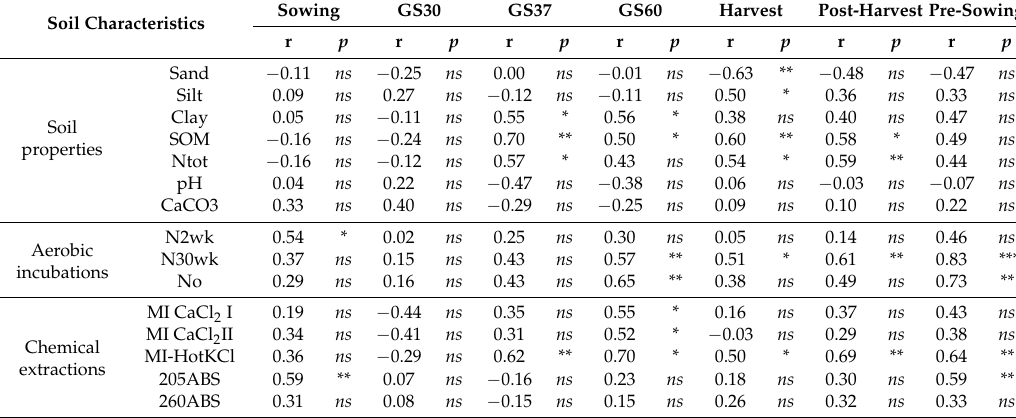
Table 3. Pearson correlation coefficients (r) between soil properties, N mineralization indices calculated from the aerobic incubations and chemical extractions with Nmin values at sowing, stem elongation (GS30), leaf flag emergence (GS37), flowering (GS60), harvest, post-harvest, and pre-sowing.